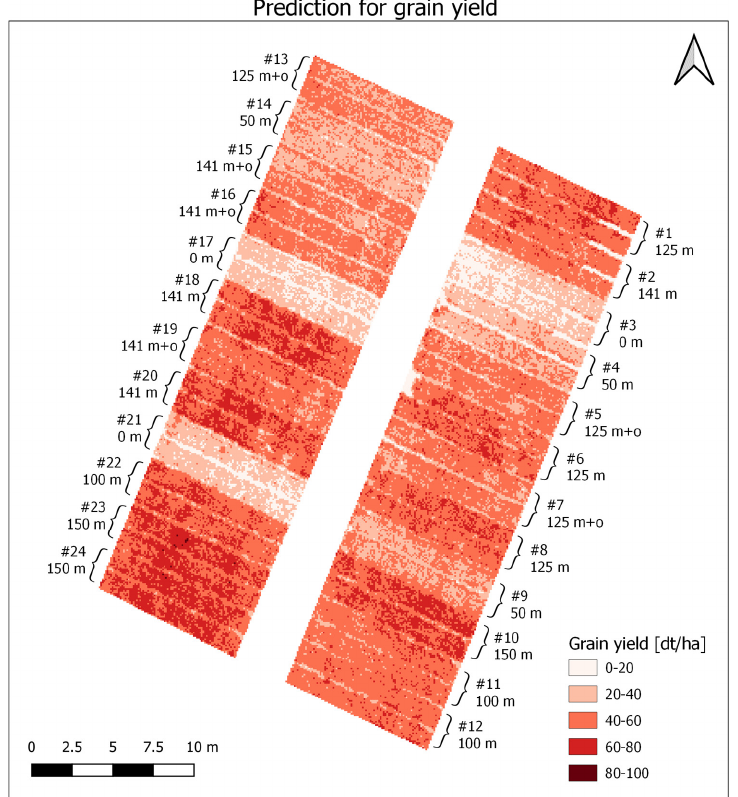
Figure 12. Spatial prediction for grain yield based on MLR model.